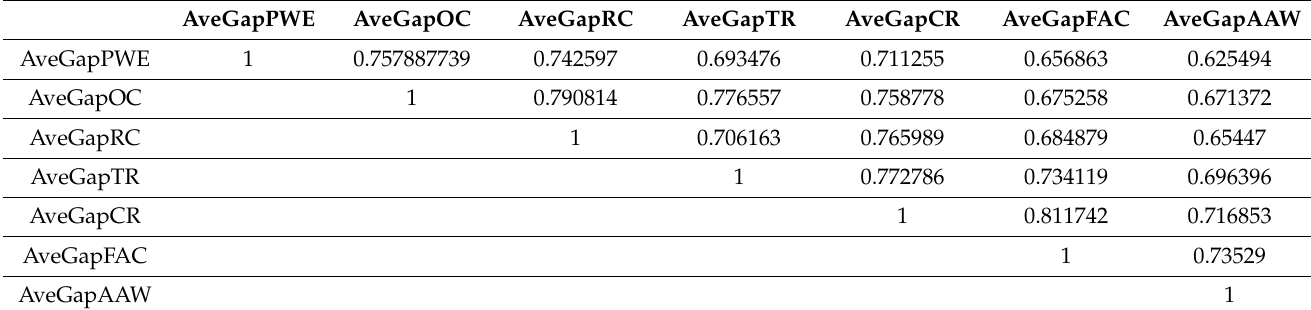
Table 9. Correlation between the seven predictors (dimensions of